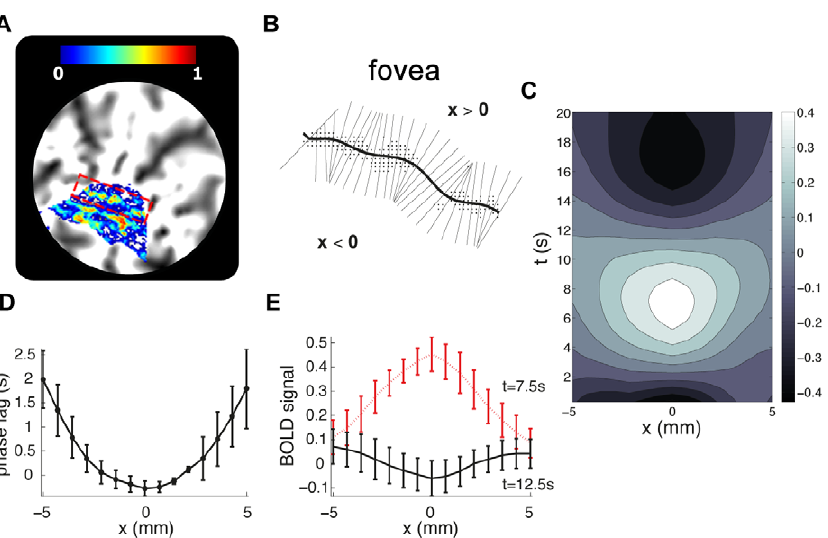
Figure 4. Traveling waves on the flattened cortical surface. A: Normalized Fourier power at the peak response frequency 0.1 Hz, calculated for voxels on the flattened surface, with the red rectangle outlining the response at 0.6 u eccentricity (the line of high activation just below is at 1.6 u ). This power level reveals which voxels respond strongly to the experimental manipulation. B: Voxels that are coherent (Methods) with the stimulus ( . 0.4) provide an estimate of the approximately straight isoeccentricity curve on the cortex (the solid curve at x=0 ). A polynomial curve is fitted to estimate the centerline, and perpendiculars are taken from this to find x . C: Averages of signals at all points with equal x , plotted vs. x and t , showing evidence of damped traveling waves in the form of sloping contours at left and right. The average percentage signal change ranges from 2 0.4 to 0.4 as indicated by the colorbar. D: Estimate of the 0.1 Hz signal delay from the stimulus onset vs. distance. E: Spatial cross-sections of the spatiotemporal response, relative to baseline, at t =7.5 s (red), showing a clear rise in amplitude, and at t =12.5 s (black), the central response has decreased and the surrounding signal remains above baseline.